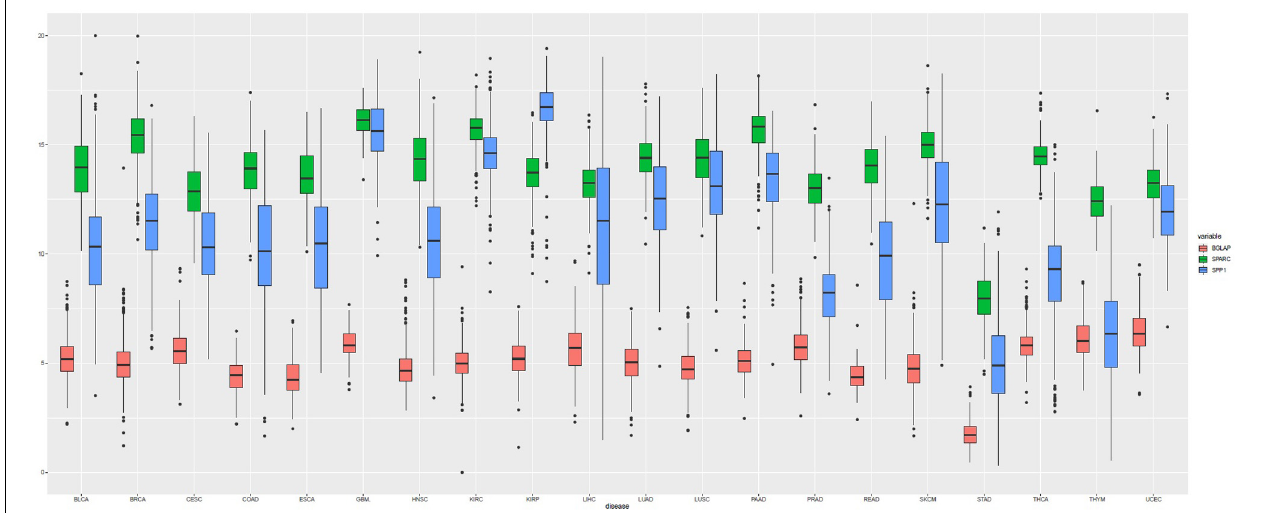
FIGURE 1 | Boxplot of the gene expression (log 2 -transformed values) of SPARC, SPP1, and BGLAP according to TCGA cancer